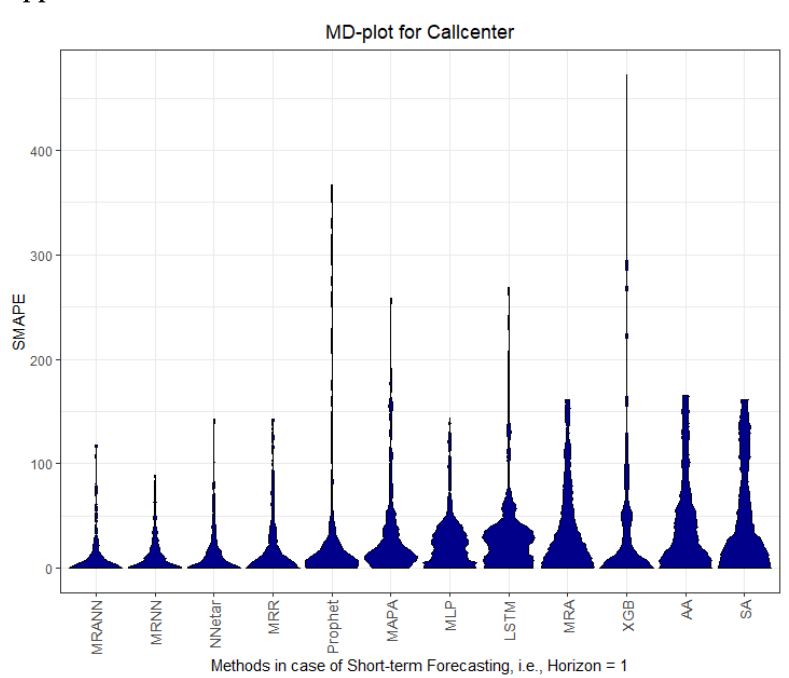
Figure A2. Mirrored Density plot of Symmetric Mean Absolute Percentage Errors (SMAPE) computed with a rolling forecasting origin for horizon 1 on dataset Callcenter.